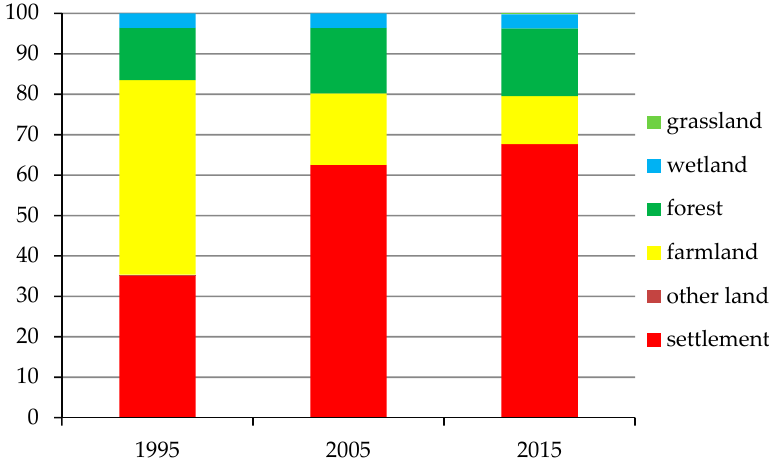
Figure 5. Changes in the proportion of different land use types (1995–2015).